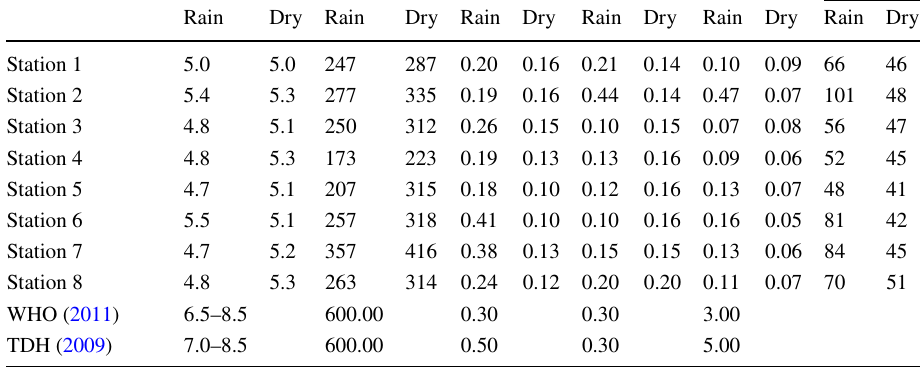
Table 2 Heavy metal concentrations (mg/L) and HPI for the individual sampling station